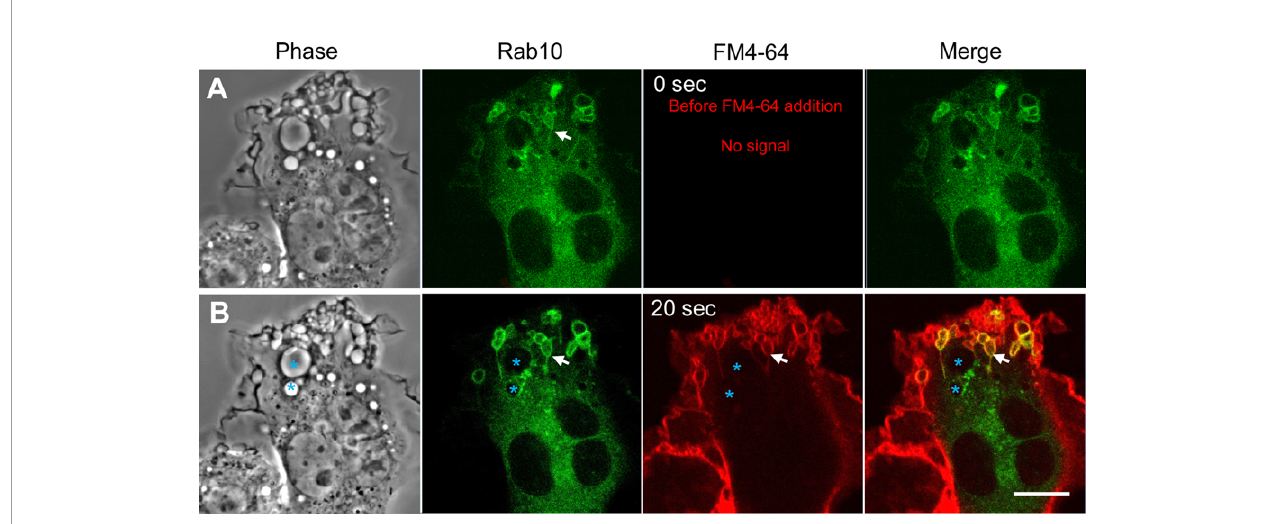
FIGURE 3 | Rab10-positive tubules originate from unclosed macropinocytic cups (premacropinosomes). Rab10-positive macropinosome-like structures were induced by PA-Rac1 ON-OFF cycling. After con fi rming the formation of Rab10-positive tubules elongated from macropinosome-like structures, the FM4-64 membrane-impermeable dye was added to the medium to label the cell surface plasma membrane during image recording. (A) Images acquired just before the addition of FM4-64 (time 0 sec). Rab10-positive tubules elongated from Rab10-positive macropinosome-like structures were con fi rmed (arrows). (B) The EGFP- Rab10 and FM4-64 images were acquired at 20 sec after the FM4-64 addition. Although phase-bright Rab10-negative macropinosomes (blue asterisks) were unlabeled with the FM4-64, Rab10-positive macropinocytic structures with extending tubules (arrows) were labeled with the FM4-64. Scale bar = 10 m